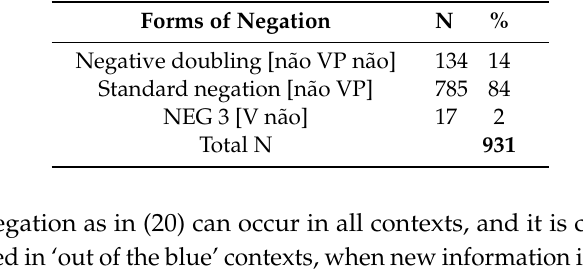
Table 1. Frequencies of types of sentential negation in Brazilian Portuguese (cf. Sousa